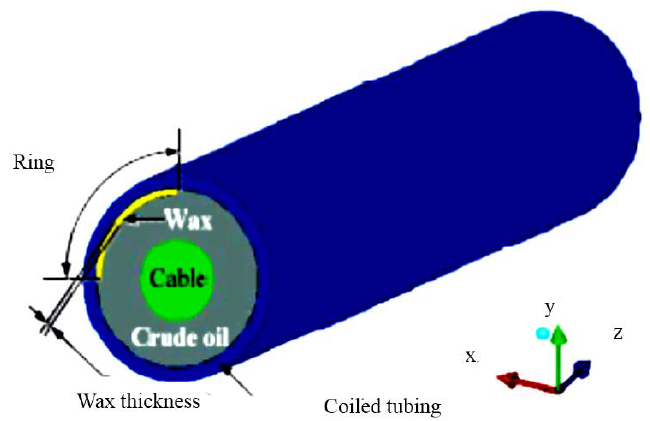
Figure 5. Cross section of flow stream line [14].